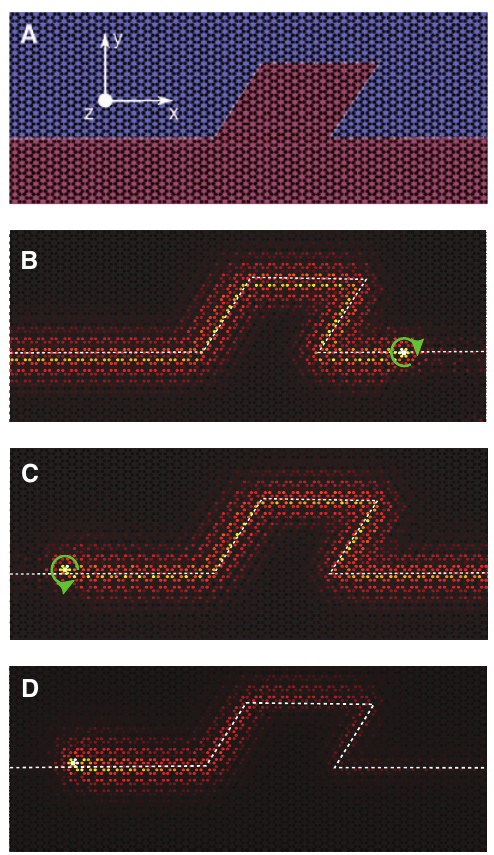
Figure 7: Helical edge states confined to the nanospheres at the boundary of a topological and a trivial plasmonic lattice. The magnitude of the dipole moment of each nanosphere | p | is shown in the figures. (A) The upper part of the array is a trivial lattice = 2.92 and the lower part is a topological lattice with with a / R 1 = 3.1 (size of the spheres is not to scale). (B and C) Rightward a / R 1 and leftward propagation of the edge states with up and down pseudo-spin. (D) The same edge state as in (B and C) in the presence of absorption